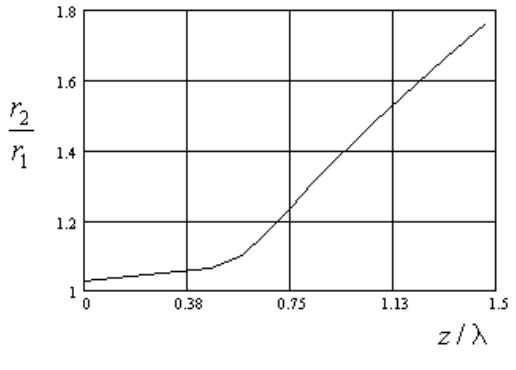
FIG. 2. Ratio r 2 (cid:3) r 1 versus the longitudinal coordinate.